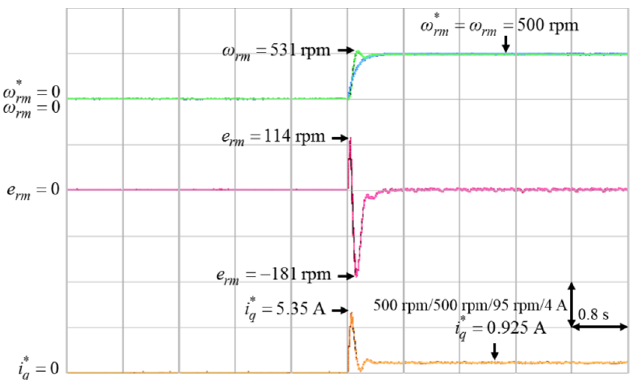
Figure 7. Experimental results of ACSM speed controller from standstill to 500 rpm in Case 3.